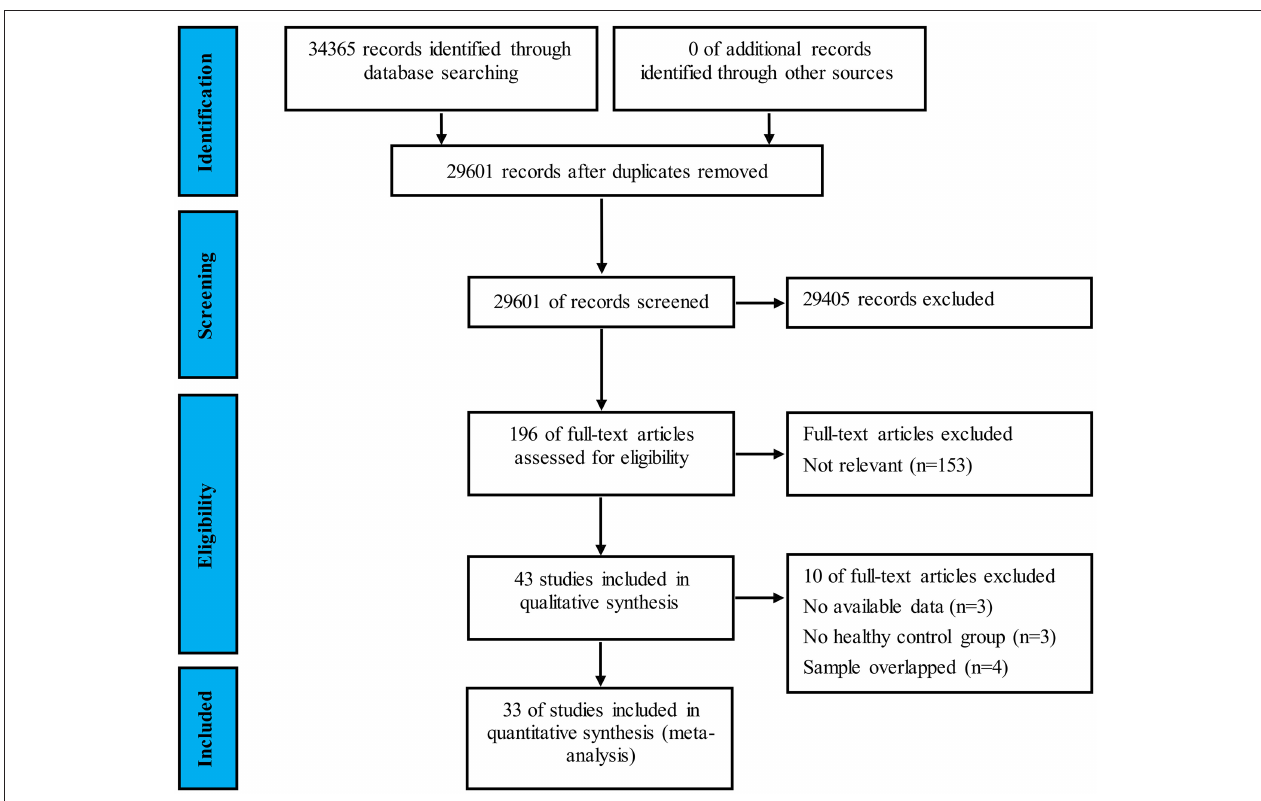
FIGURE 1 | PRISMA flowchart displaying study screening and selection